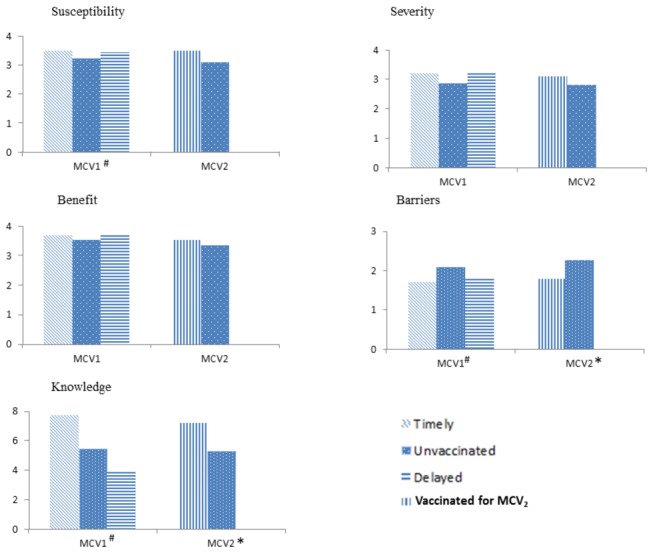
Scores of PMT model for MCV1 and MCV2.
#Significant difference among three groups(P<0.05). *Significant difference between two groups(P<0.05).